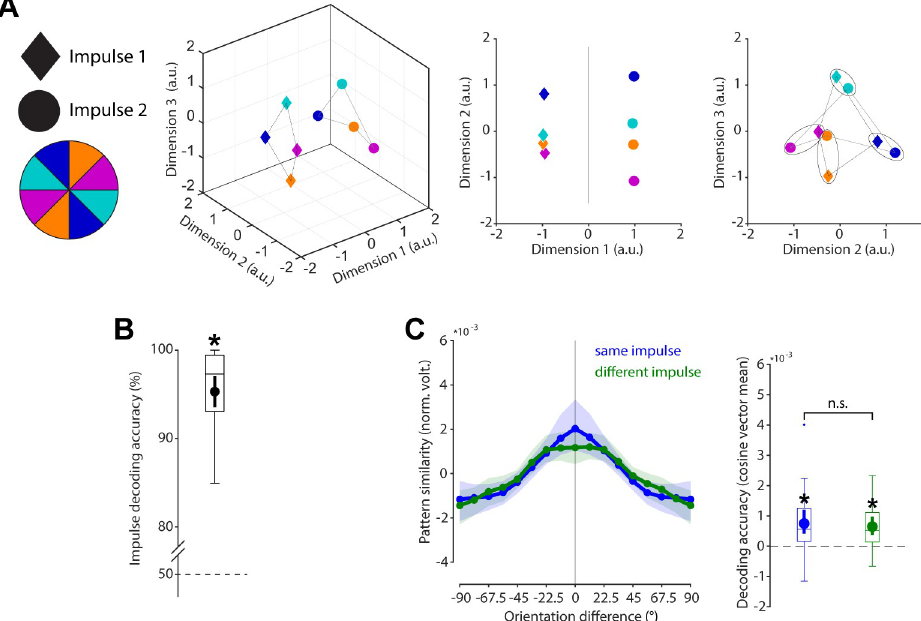
Fig 4. Cross-generalisation of coding scheme between impulses. (A) Visualisation of orientation and impulse code in state space. The first dimension discriminates between impulses. The second and third dimensions code the orientation space in both impulses. (B) Trial-wise accuracy (%) of impulse decoding. (C) Orientation decoding within each impulse (blue) and orientation code cross-generalisation between impulses (green). Error shadings and error bars are 95% CI of the mean. Asterisks indicate significant decoding accuracies or cross-generalisation ( p < 0.05). Data available at osf.io/cn8zf. a.u., arbitrary units; norm. volt., normalised voltage; n.s., not significant.